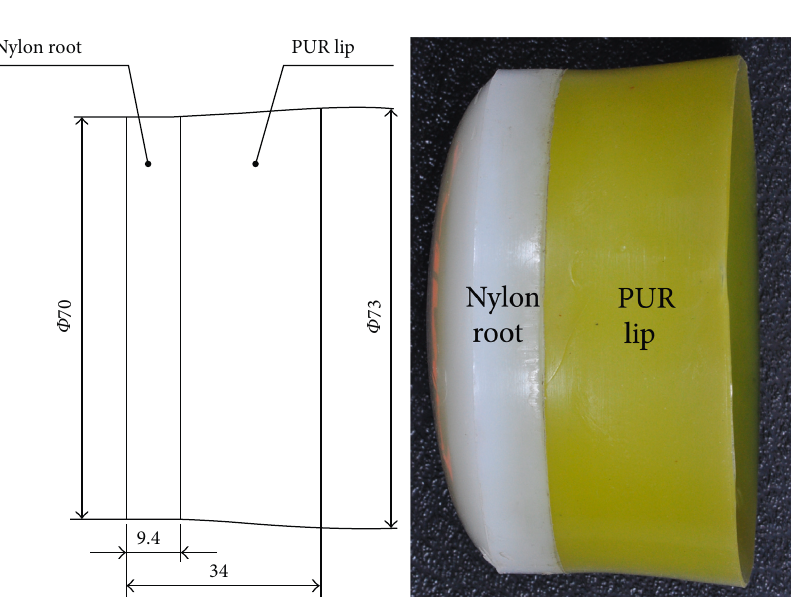
Figure 2: Test piston size and its original